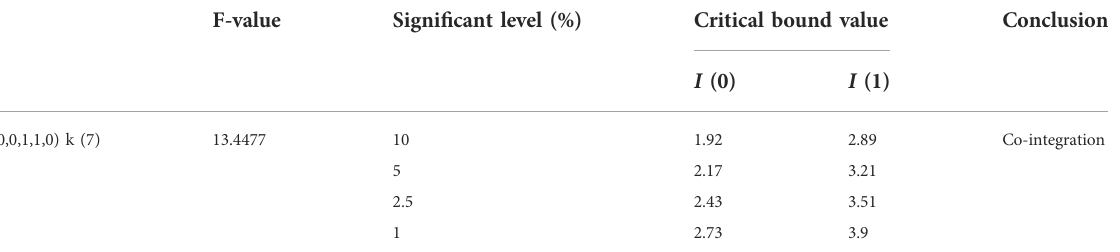
TABLE 7 ARDL Bound Test for co-integration.